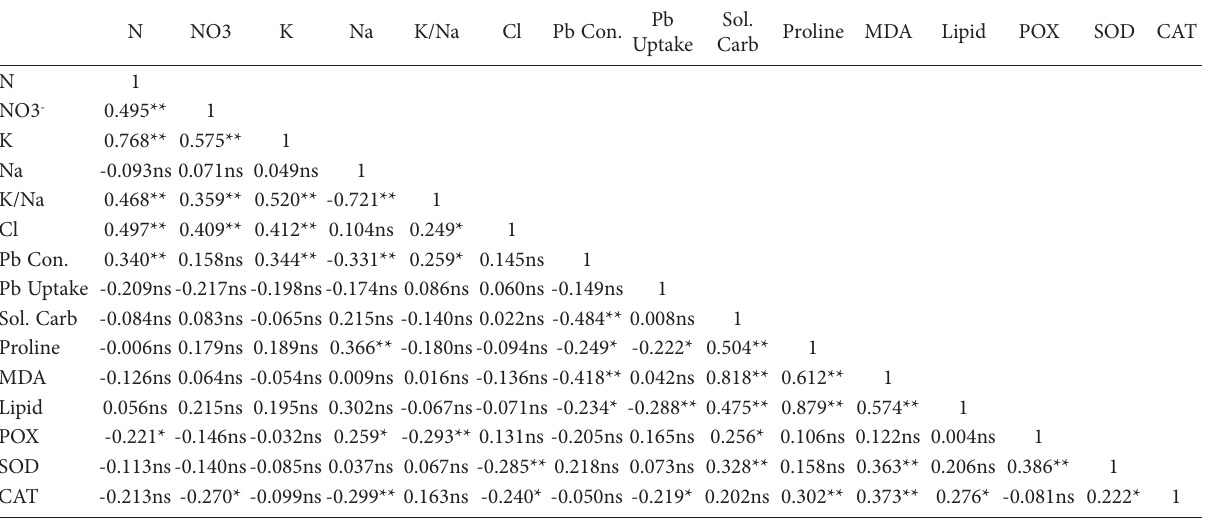
Table 2. Pearson correlation coefficients between